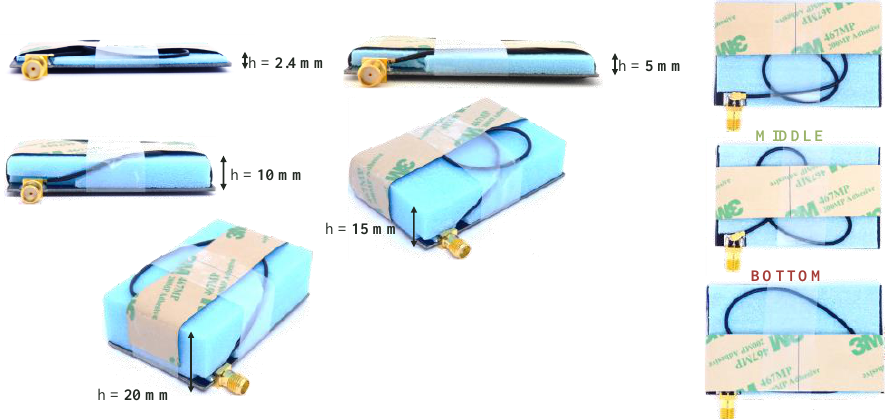
Figure 12. FPC antenna on a 65 mm × 42 mm PCB at several heights (2.4 mm, 5 mm, 10 mm, 15 mm, and 20 mm) and for three different positions on the PCB. In this small PCB, the FPC antenna must be bent to fit on the PCB.